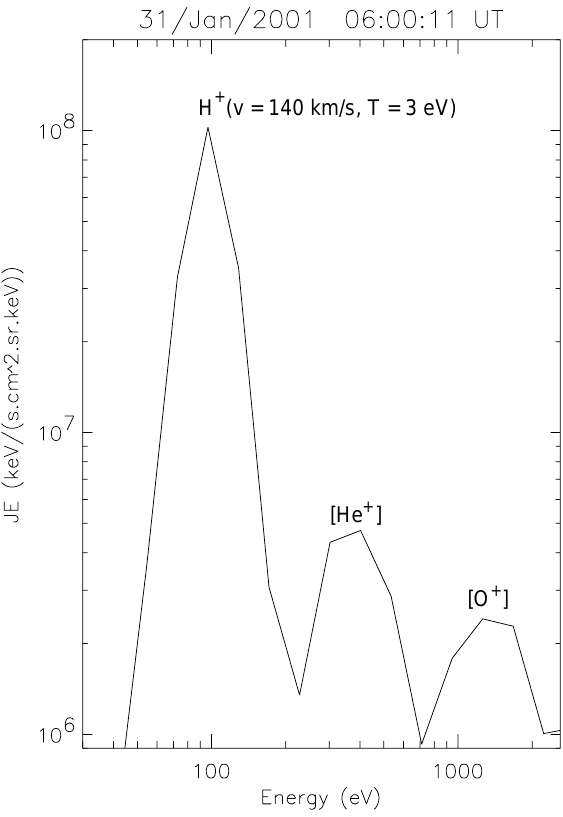
Fig. 7. Ion energy spectra taken in the plasma flow direction by the non-mass resolving CIS-2 spectrometer. Note the appearance of peaks corresponding to H + , He + and O + with a velocity of ∼ 140km/s, i.e. an electric field of ∼ 2 . 8mV/m. The H + tem- perature estimated from a maxwellian fit is close to